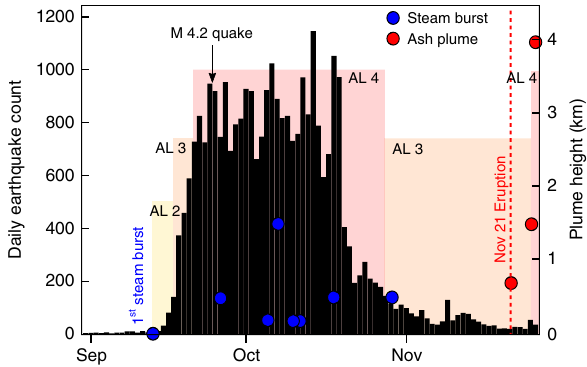
Fig. 2 Timeline of observations during the 2017 seismic crisis at Agung volcano. Black histogram shows the daily number of seismic events provided by the Indonesian Center for Volcanology and Geological Hazard Mitigation (CVGHM). Blue and red circles indicate the height of steam bursts and ash plumes, respectively. The coloured background indicates the different Alert Levels provided by the CVGHM during swarms, combined with petrological constraints to provide new insights into the structure and connectivity of magmatic systems.